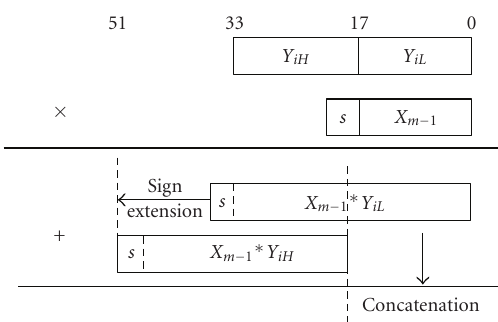
Figure 5: 18 × 34-bit multiplication using 18 × 18-bit embedded